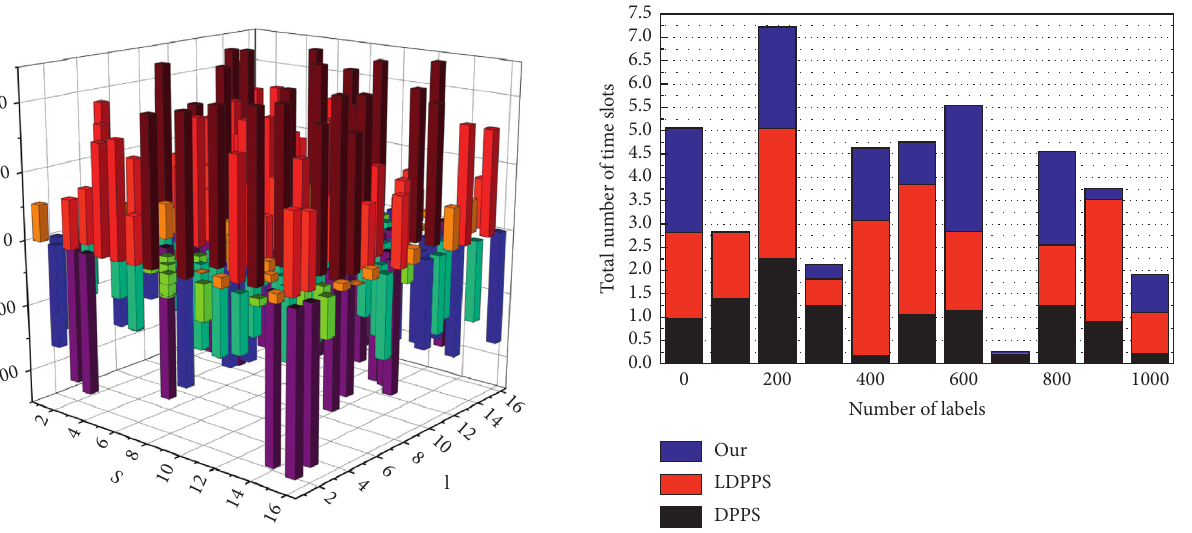
Figure 6: S/I/C normalized weights under A